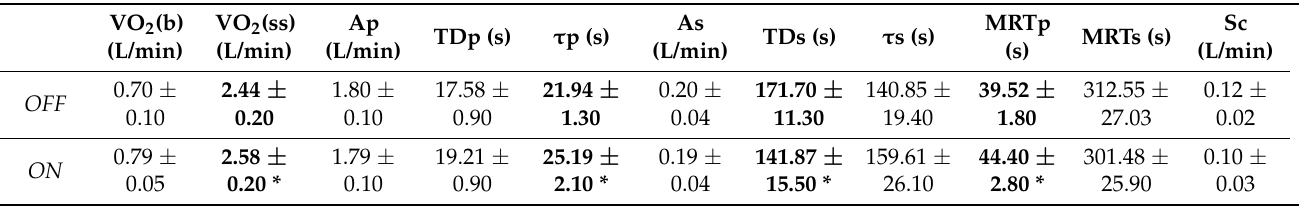
Muscle oxygenation parameters. HHb on-kinetics analysis, in both conditions, for a representative subject are shown in Figure 3. Time values of HHb were significantly lower during ON than OFF conditions both at the primary, with faster τ p (t(9) = 2.96; p = 0.008; mean diff. = − 1.37; d = − 0.88) and mean response time (t(9) = 2.65; p = 0.013; mean diff. = − 1.39; d = − 0.82), and at the secondary component with faster mean response time (t(9)